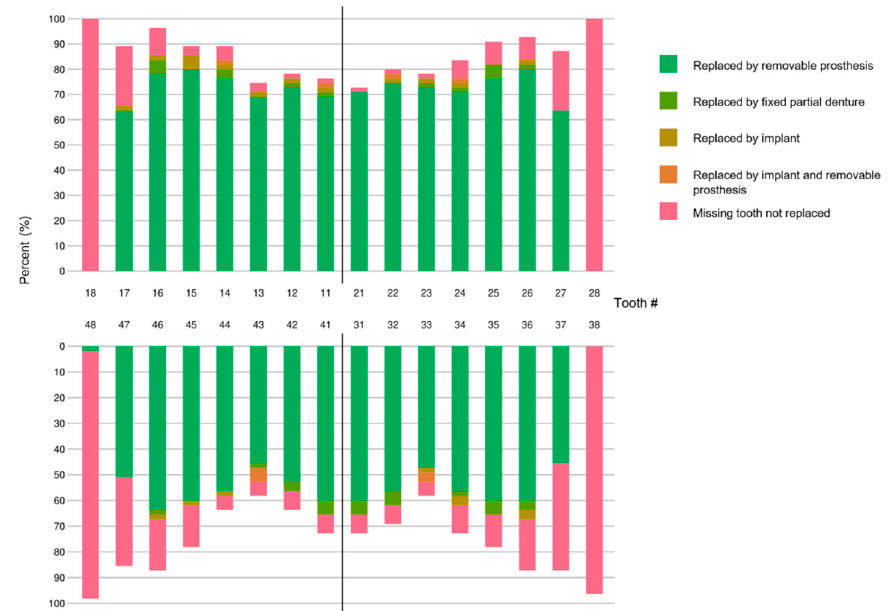
Figure 1. Prosthetically replaced teeth in the centenarian population ( n = 55) depicted according to the FDI notation.